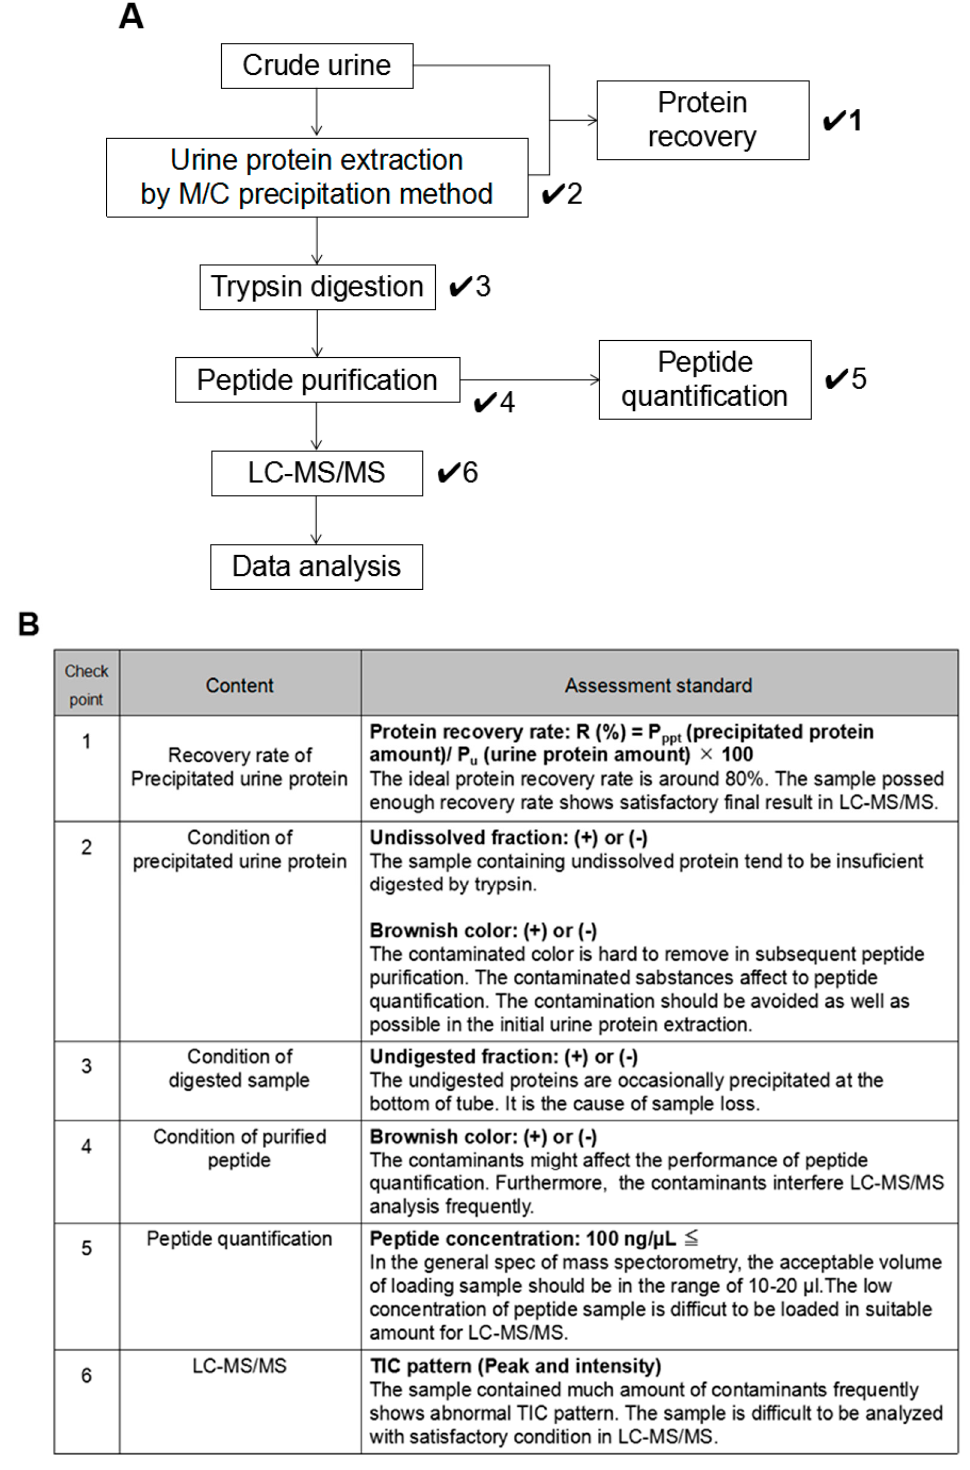
Figure 4. An optimized workflow for urine proteomics. ( A ) A workflow of urine protein preparation in LC-MS/MS analysis. Total of six checkpoints was established as indicated “ ✔ .” ( B ) Summary of each checkpoint. Evaluation standards in each checkpoint were listed.